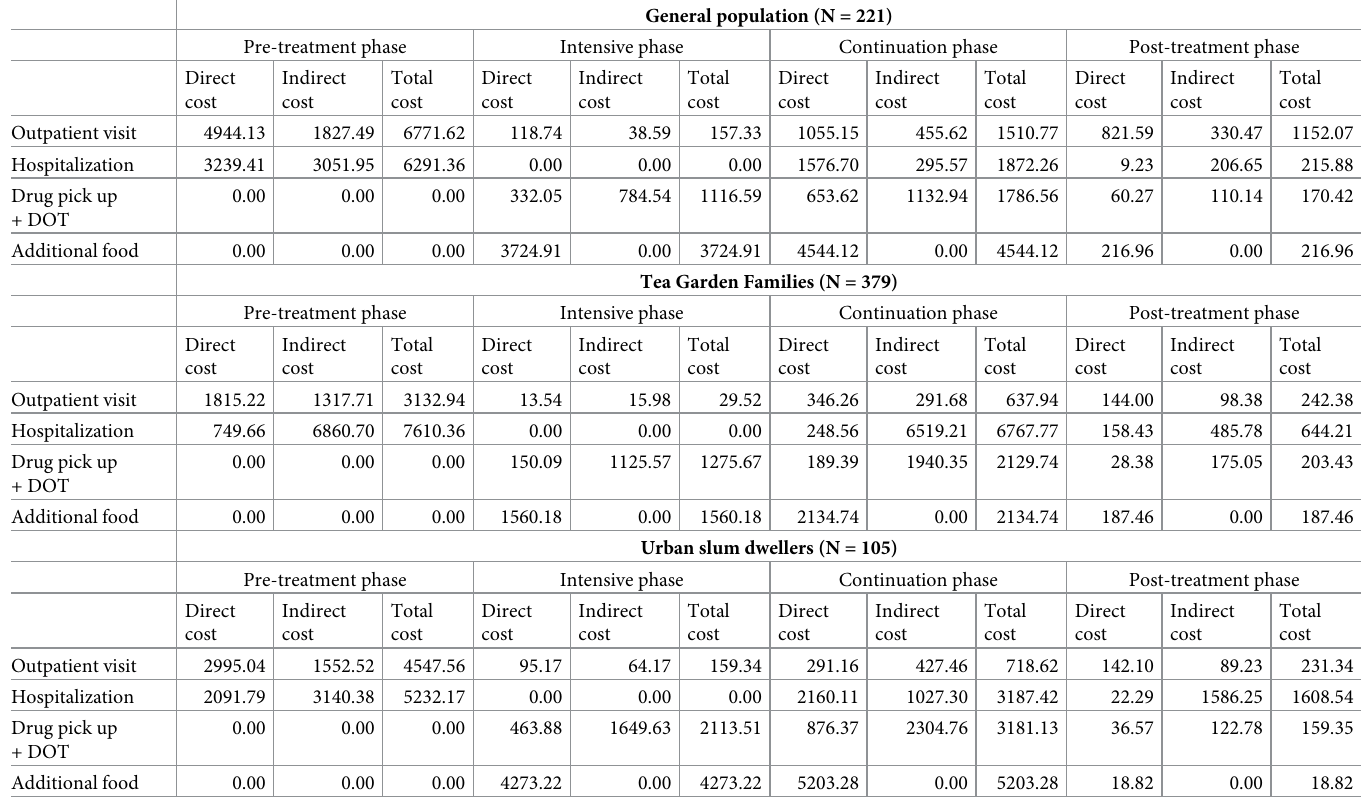
Table 3. Costs of tuberculosis treatment (US$